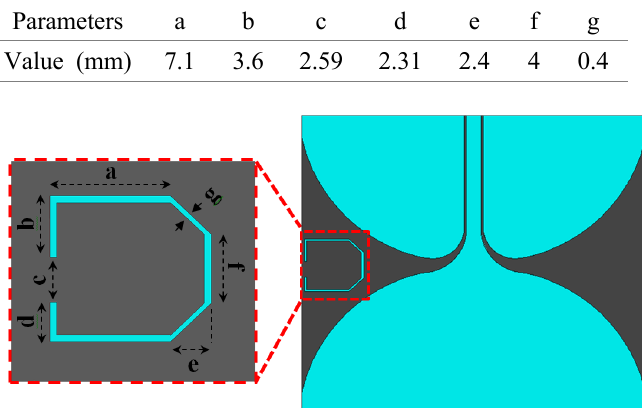
Table 2: Parasitic SRR optimal parameters